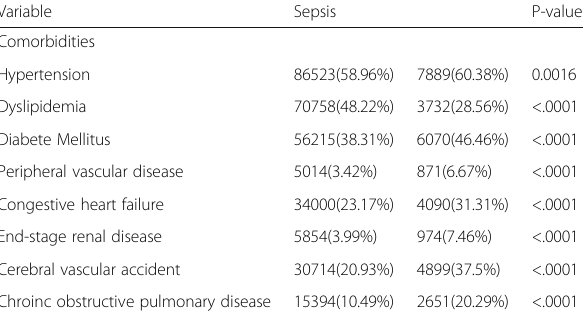
Table 61 (abstract A188). Characteristics in patients with/without sepsis-2